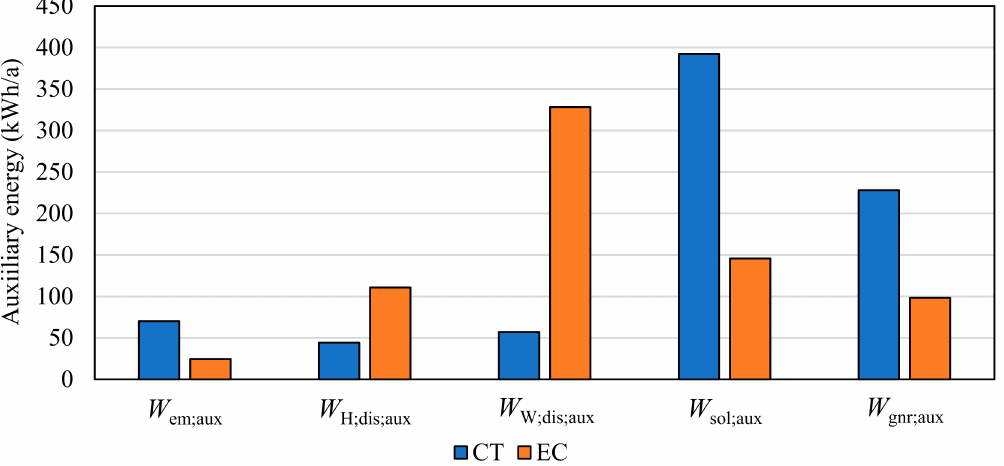
Figure 18. Comparison of auxiliary energy consumption of each